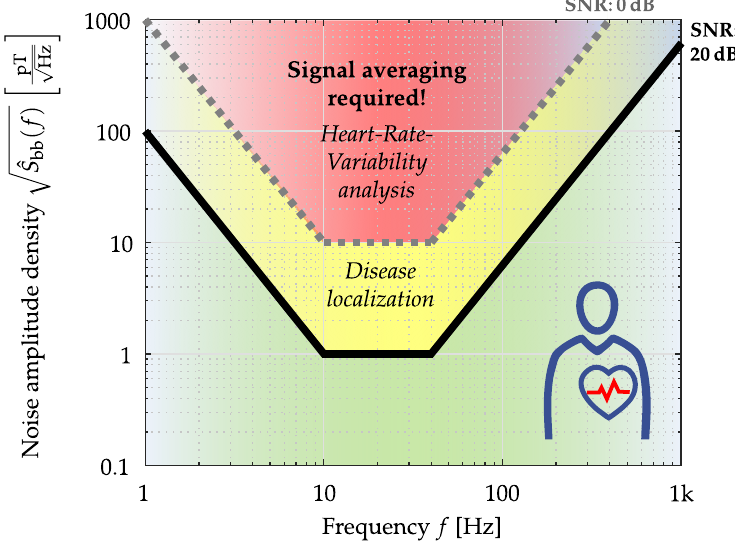
Figure 13. Application-specific noise requirements for MCG (Heart-Rate-Variability analyses by de- tection of the R-Peak; Disease localization by solving the inverse problem) specified by the amplitude density. Sensor positioned directly over the chest [55].